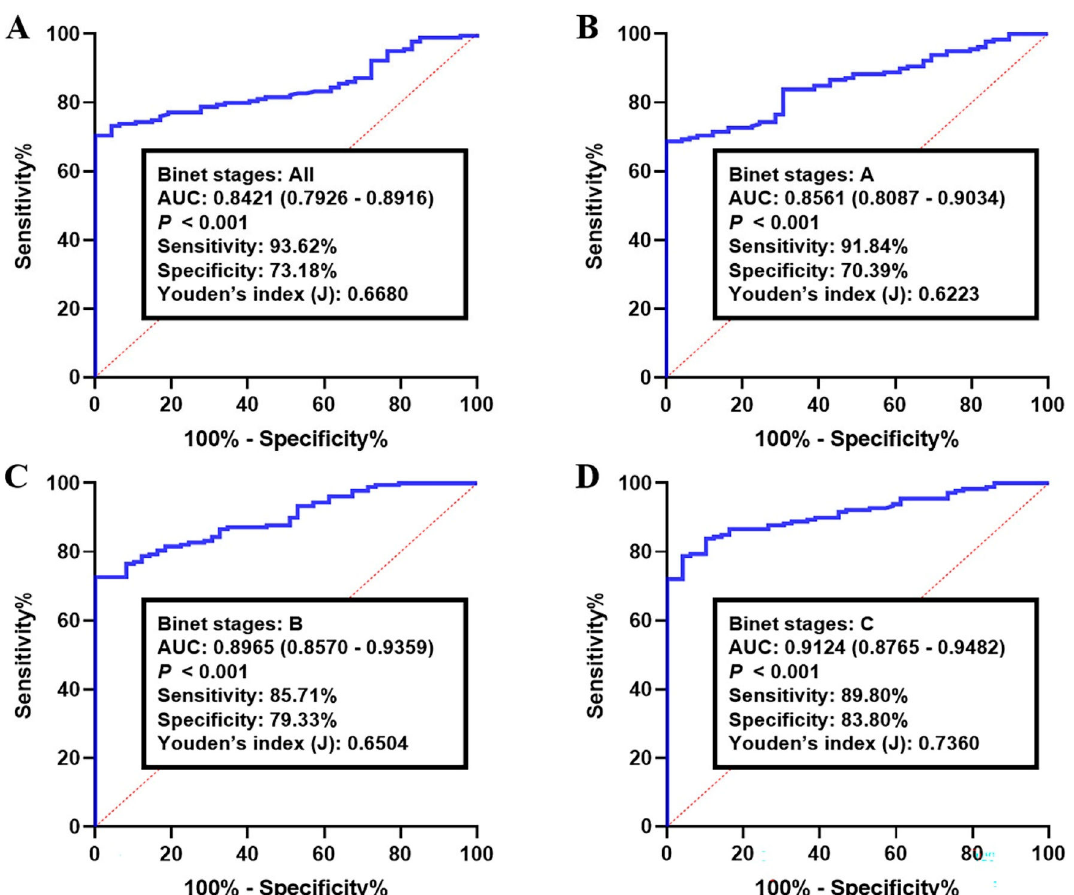
Figure 3. Receiver operating characteristics (ROC) curve analysis of the log it model with the cir- cKAT6A/circLNPEP/circMDM2/circMYH9 panel in the validation set I. The study group consisted of 220 CLLs and healthy B-lymphocytes. Using the optimal cutoff value of 0.7262, the diagnostic performance of the circRNA panel for discriminating CLLs with ( A ) all Binet stages, ( B ) Binet stage A, ( C ) Binet stage B, and ( D ) Binet stage C from healthy samples were examined. Log it (p) of the model was 0.7262 + 0.7690 × CircKAT6A + 0.1786 × CircLNPEP − 0.2246 × CircMDM2 + 0.9938 × CircMYH9. ROC curve analysis of the proposed circRNA-biomarker panel in validation set II indicated a similar diagnostic efficacy in a larger sample population. The corresponding AUC for all CLLs (Binet A–C stages) was 0.8852 (95% CI: 0.8534–0.9171), with a sensitivity of 93.86% and a specificity of 73.33% ( p < 0.001, Figure 4A). Accordingly, the diagnostic accuracy of the panel in Binet stage A samples was 0.8491 (95% CI: 0.8127–0.8855; sensitivity: 97.47% and specificity: 72.06%, Figure 4B), while CLLs with Binet stage B showed an AUC of 0.8737 (95% CI: 0.8403–0.9071; sensitivity: 88.61% and specificity: 77.14%, Figure 4C). Meanwhile, the analyzing of CLL data profiles with Binet stage C resulted in an overall AUC of 0.9255 (95% CI: 0.9009–0.9502) along with a sensitivity of 89.87% and a specificity of 83.18% ( p < 0.001, Figure